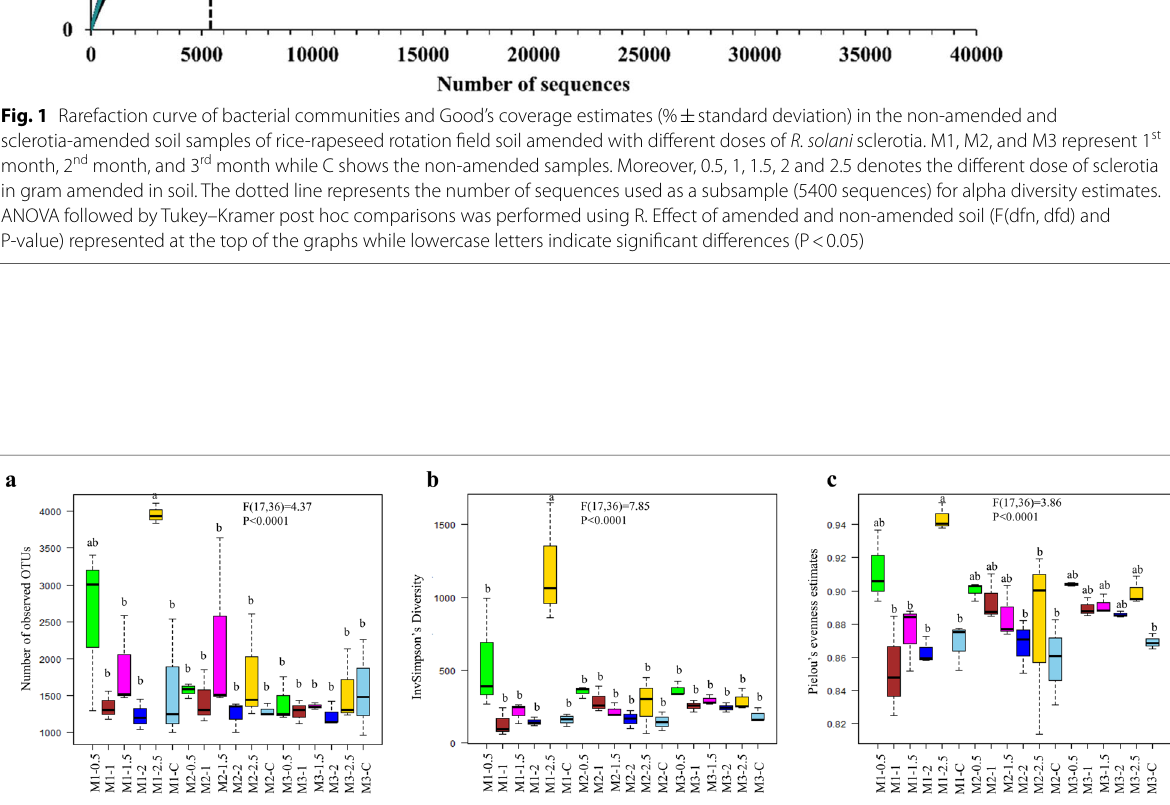
Fig. 2 Alpha diversity indices calculated for bacterial communities between the non-amended and sclerotia-amended soil samples in rice-rapeseed rotation field soil amended with different doses of R. solani sclerotia. M1, M2, and M3 represent 1 st month, 2 nd month, and 3 rd month while C shows non-amended samples. Moreover, 0.5, 1, 1.5, 2 and 2.5 denotes the different dose of sclerotia in gram amended in soil. ANOVA followed by Tukey–Kramer post hoc comparisons was performed using R. Effect of the amended and non-amended soil (F(dfn, dfd) and P -value) represented at the top of the graphs while lowercase letters indicate significant differences ( P <